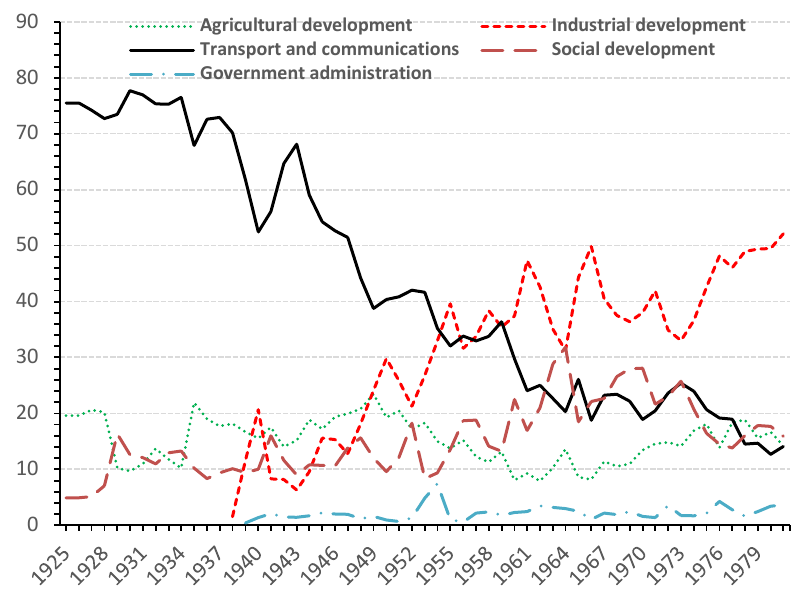
Graph 4 : Evolution of the components of public investment in relation to the total (in percentages)